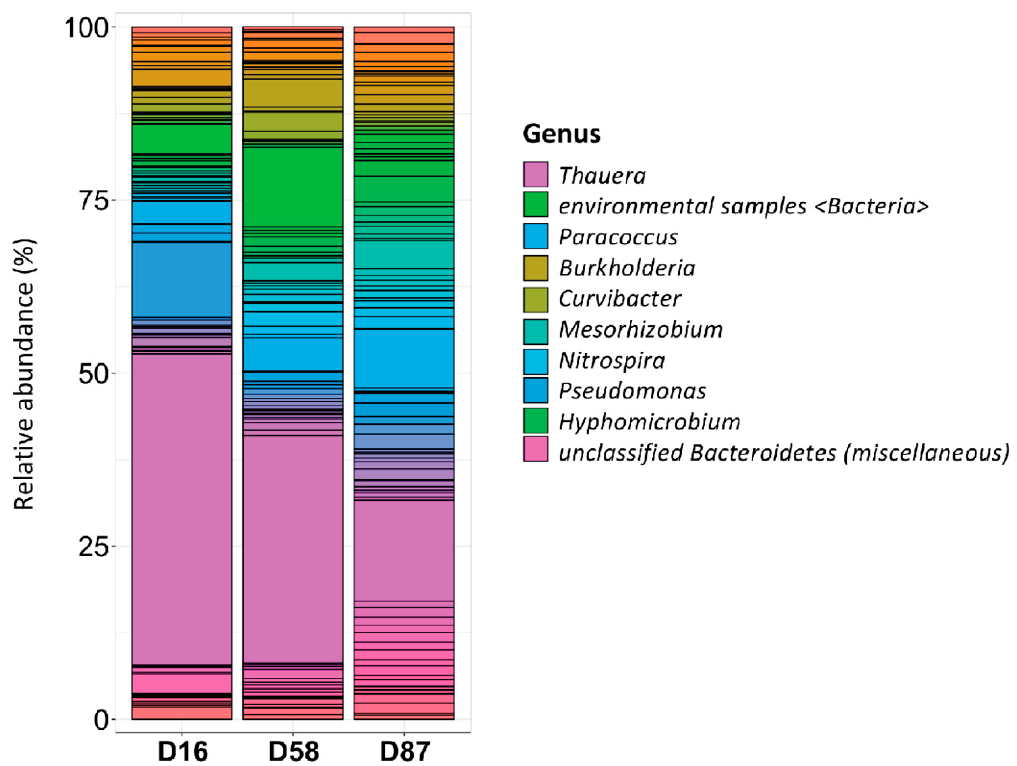
Figure 9. Prokaryotic community taxonomic analysis of the metatranscriptomic data. Distribution of the top identified bacterial organisms at genus level, identified in the three time points for the metatranscriptome analysis. The scale in the y axis reflects the normalized relative abundance percentages (%). Black lines within each bar separates each genus into different species.